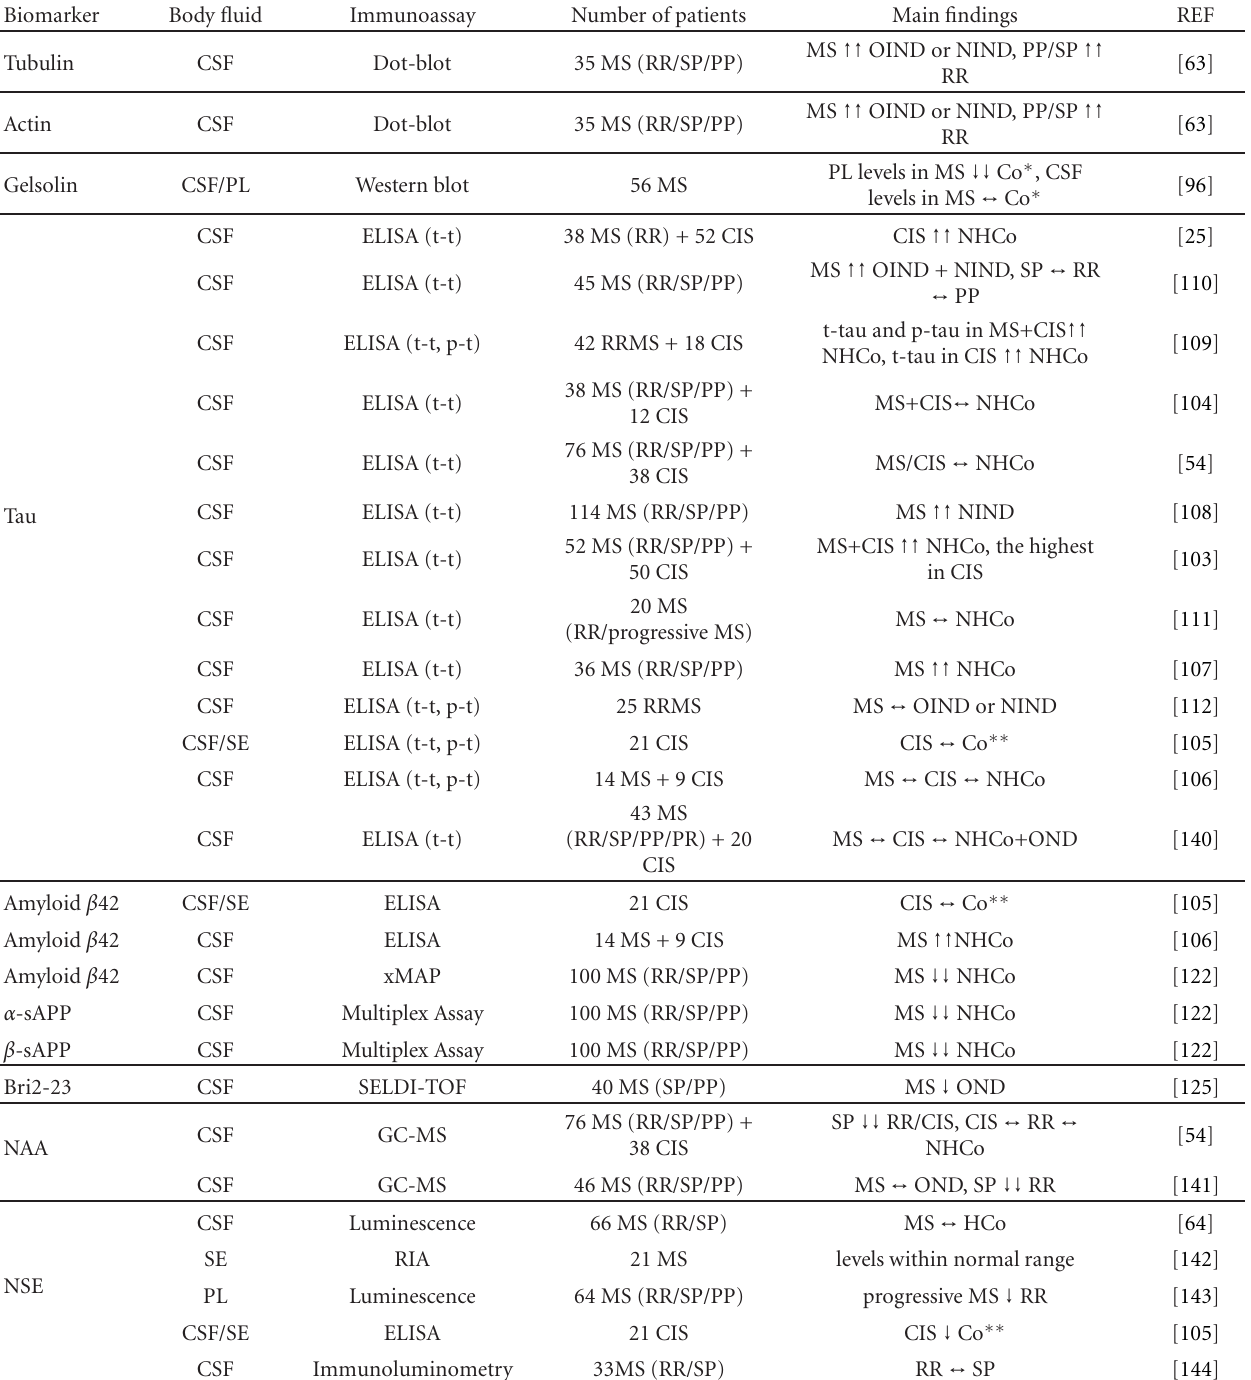
Table 4: Cytoplasmic, non-neurofilament biomarkers of neuroaxonal damage in the cerebrospinal fluid (CSF) and blood of patients with multiple sclerosis (MS) and/or clinically isolated syndrome suggestive of MS